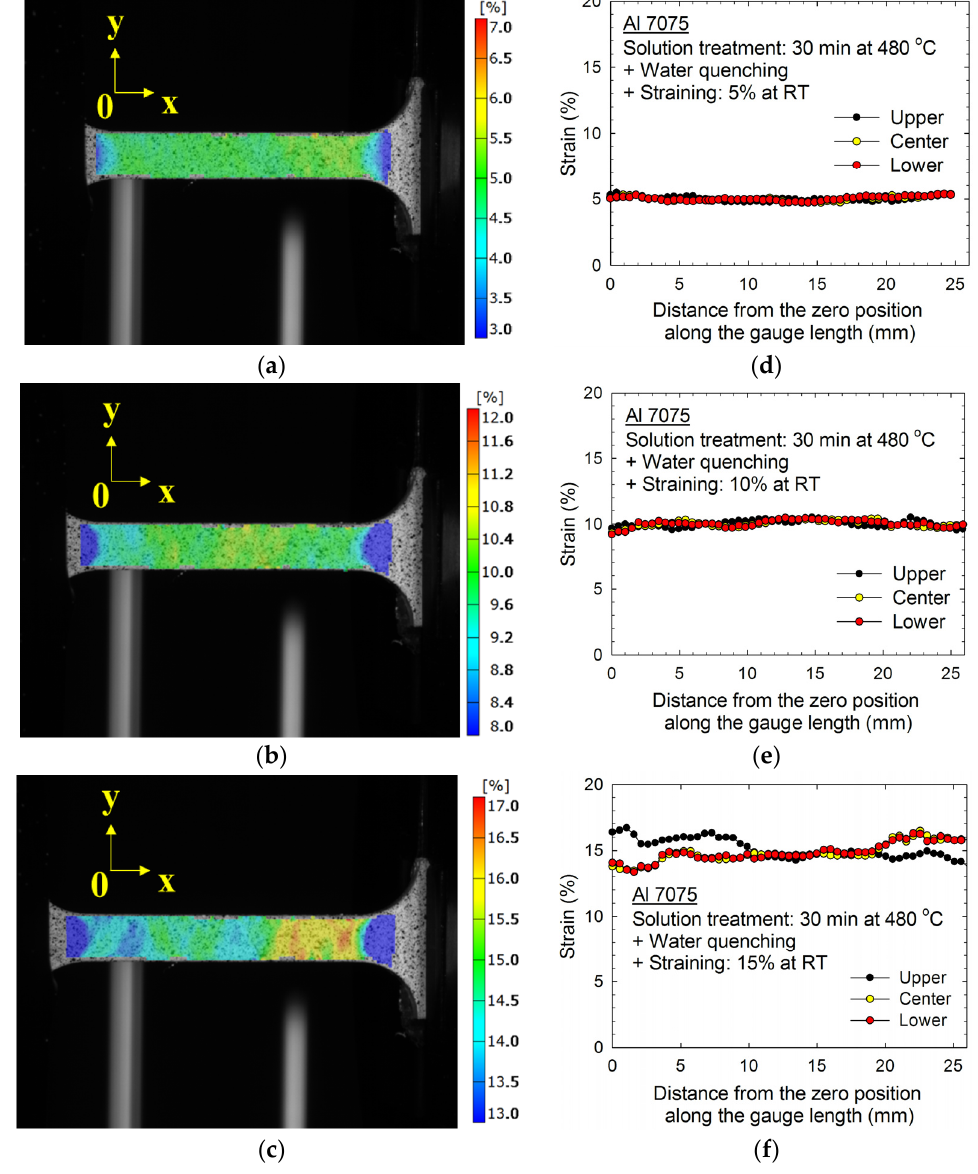
Figure 4. ( a – c ) The strain maps and ( d – f ) the plots of the strain distributions at the upper, center, and lower sections along the gauge lengths of the Al 7075 alloy after straining at RT for 5%, 10%, and 15%, respectively. The individual values of strain are represented by a set of color keys placed in the right of each strain map.